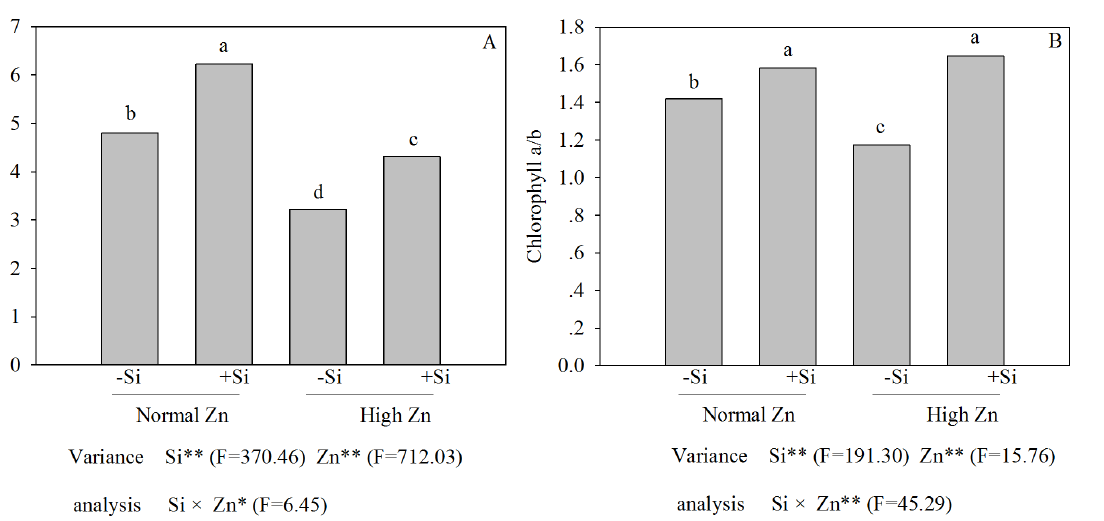
Figure 4. Chlorophyll (a + b) content (A) and the radio of Chlorophyll a/b(B) of Zn-sensitive rice ( Oryza sativa L.) cultivar grown hydroponically with either normal (0.15 m M) or high (2 mM) Zn without or with 1.5 mM Si for seven days. Data are means ¡ S.D. of three replicates. Note:P-values indicate significance level based on two-way ANOVA. * P , 0.05, ** P , 0.01. Data followed by different letters are significantly different according to ANOVA (P ,